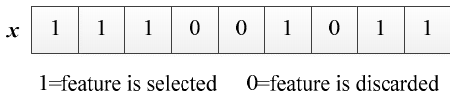
Figure 1. The encoding of a particle for feature selection.